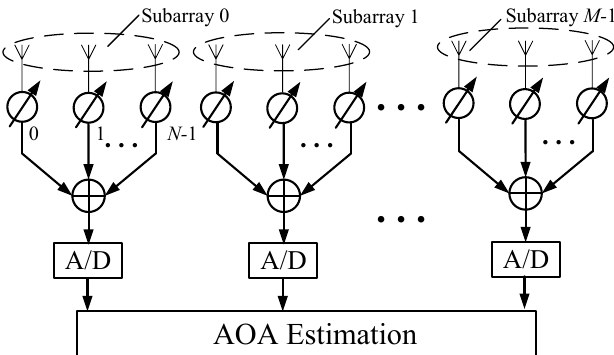
Figure 1. Illustration of a localized array with M subarrays, where the RF and down conversion components are omitted for